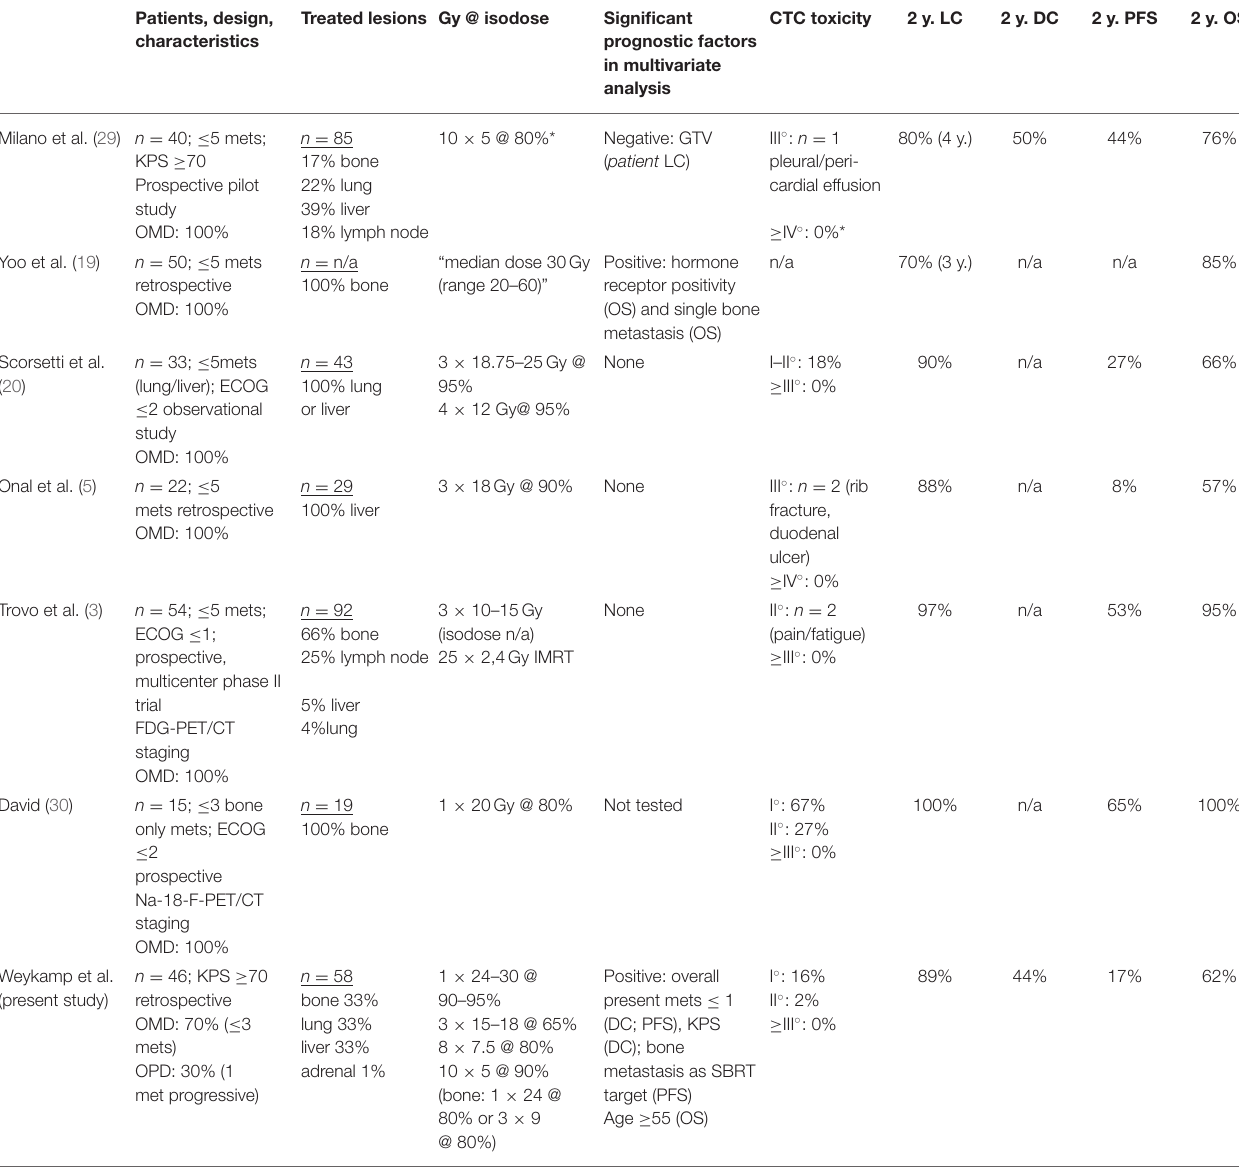
TABLE 6 | Prospective and retrospective studies investigating ablative, stereotactic radiotherapy for oligometastastic breast cancer. Patients, design, Treated lesions Gy @ isodose Significant characteristics